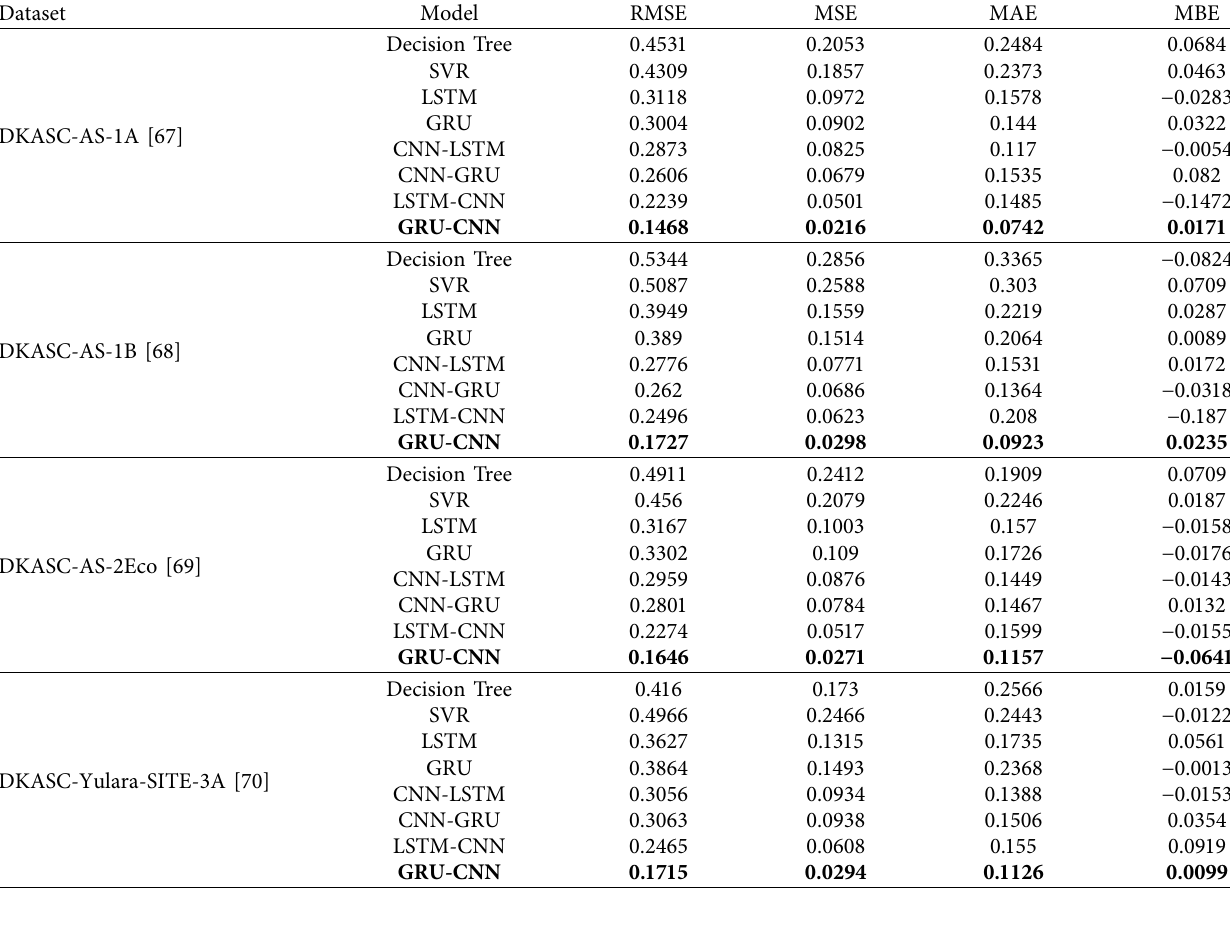
Table 4: Comparative analysis of the proposed model with different existing deep learning models. Herein, DKASC-AS-1A, DKASC-AS-1B, DKASC-AS-2Eco, and DKASC-Yulara-SITE-3A represent the PV power datasets. The bold text shows the experimental result of the proposed models on one-hour ahead PV power forecasting.